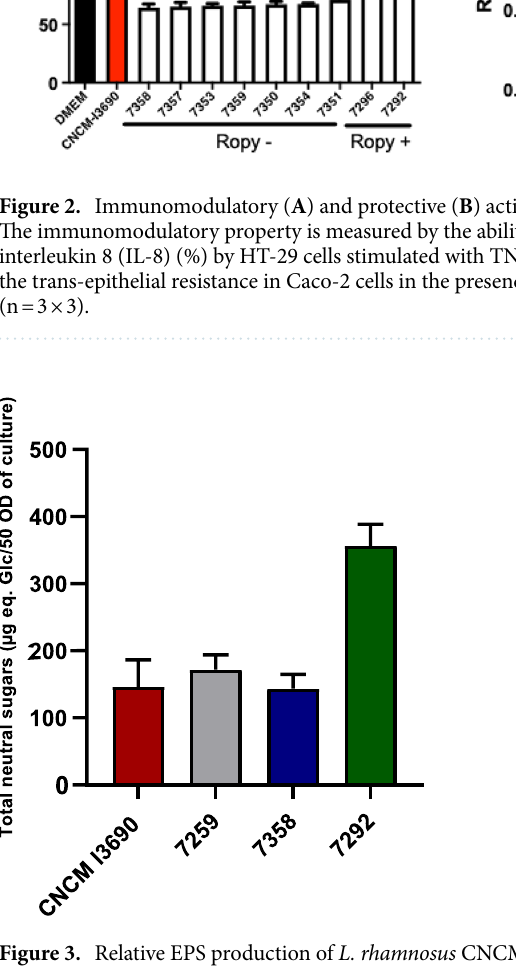
Figure 3. Relative EPS production of L. rhamnosus CNCM I-3690 and its